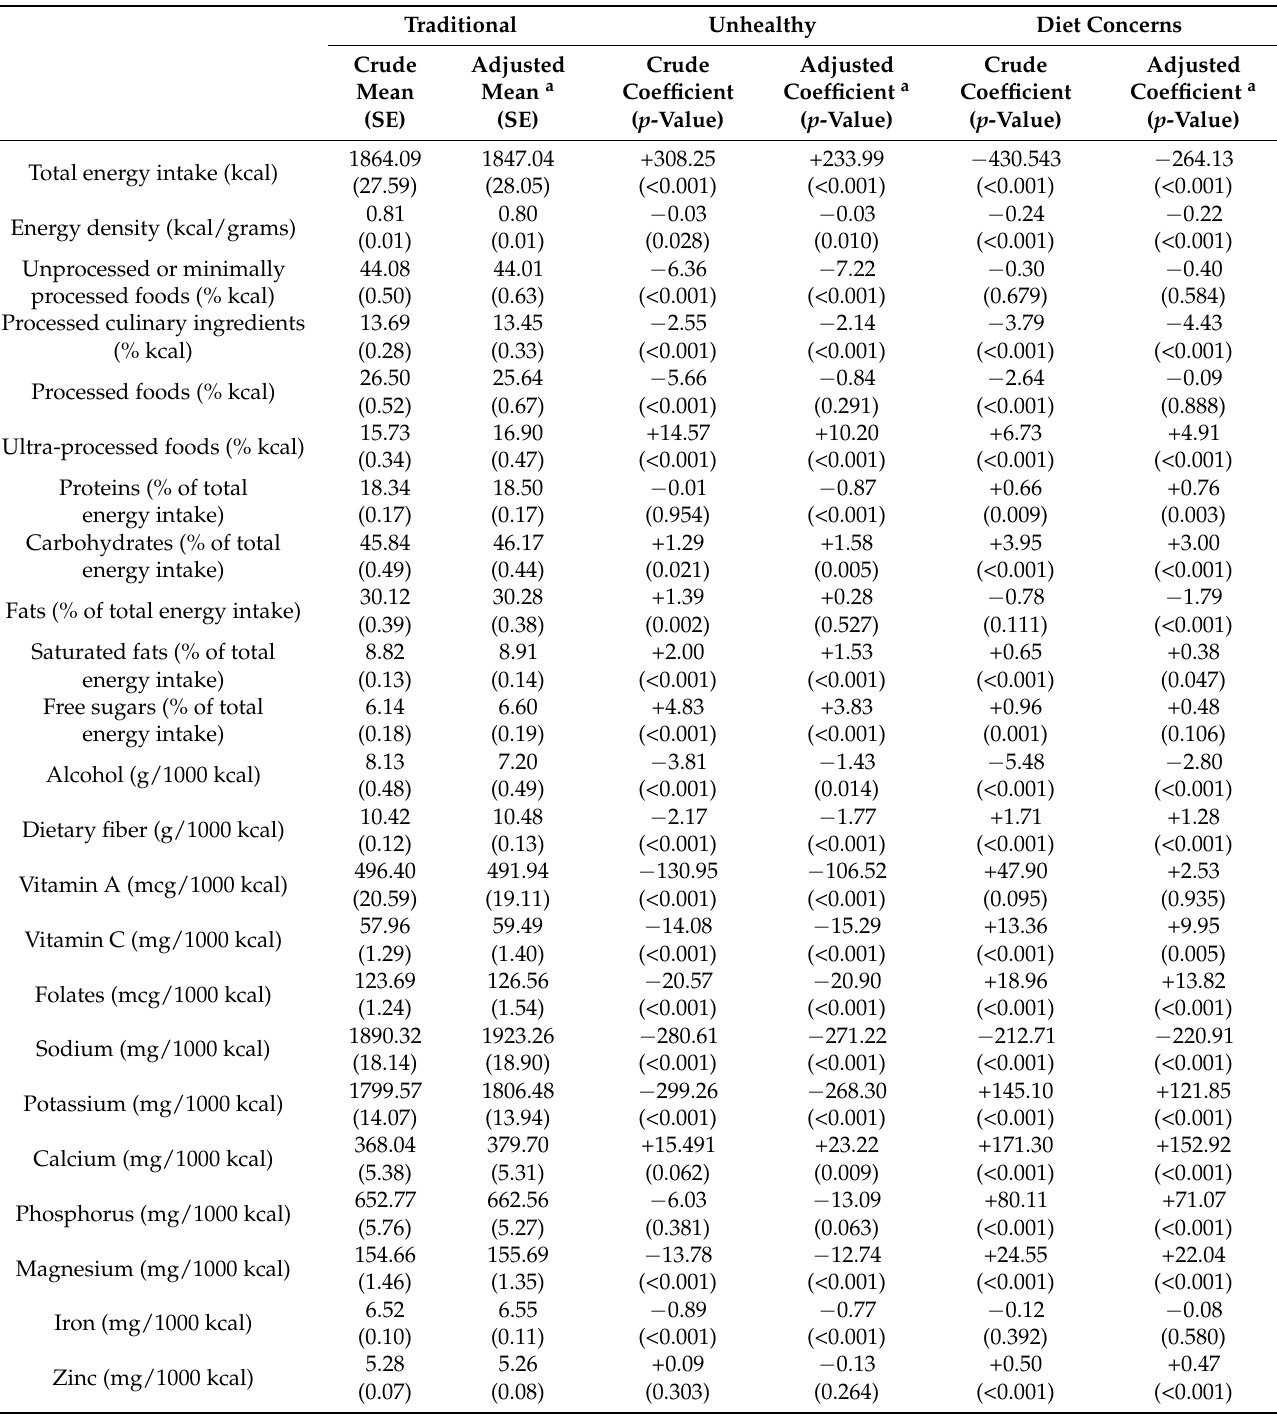
Table 4. Nutritional intake according to dietary patterns (DPs) derived by latent class analysis among Portuguese population aged 18–84: The UPPER